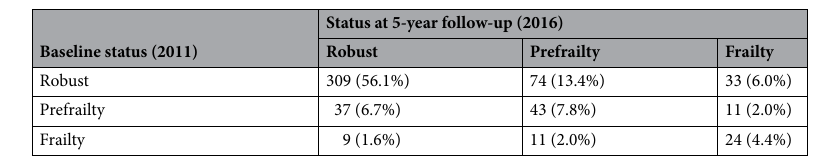
Table 1. Transitions of seven dimensions in the Kihon Checklist from the baseline to the 5-year follow-up. ADL activities of daily living. *Statistically significant at the level of p < 0.05.